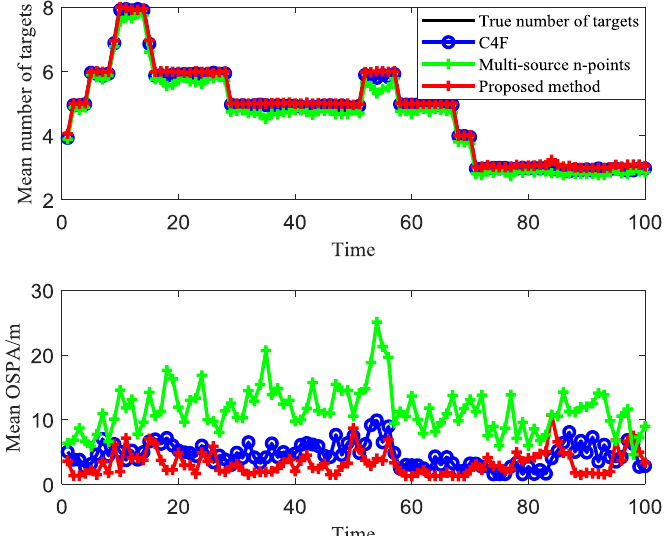
Figure 8. Clustering results of 20 sensors and different clusters (differently colored “o” and “□”), true target positions (red “□”), cluster centers of MS n-points (red “+”), C4F (blue “o”) and proposed method (black “o”).